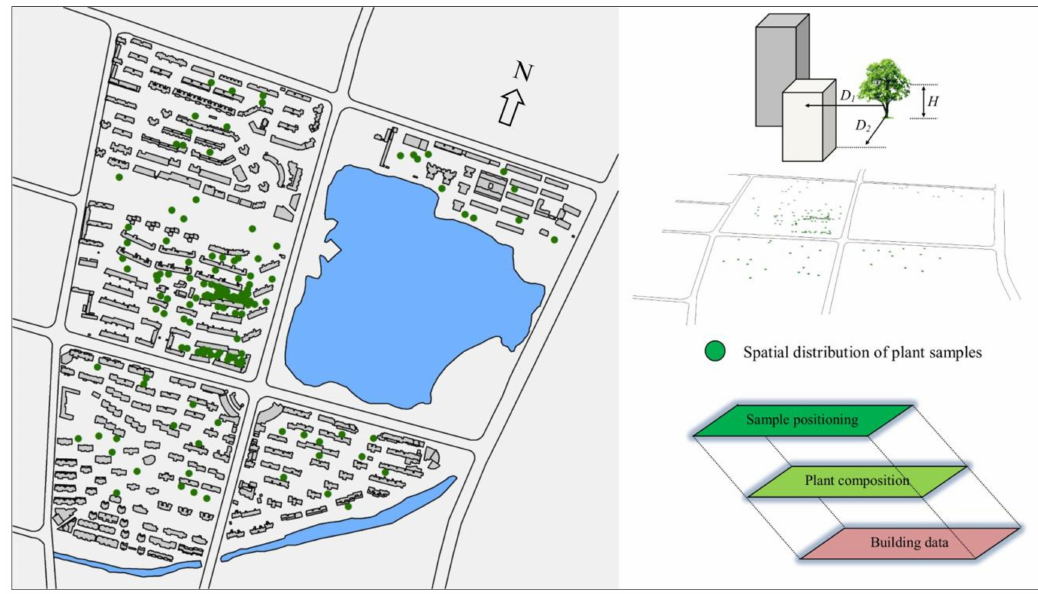
Figure 3. Sample distribution and data management based on ArcGIS.